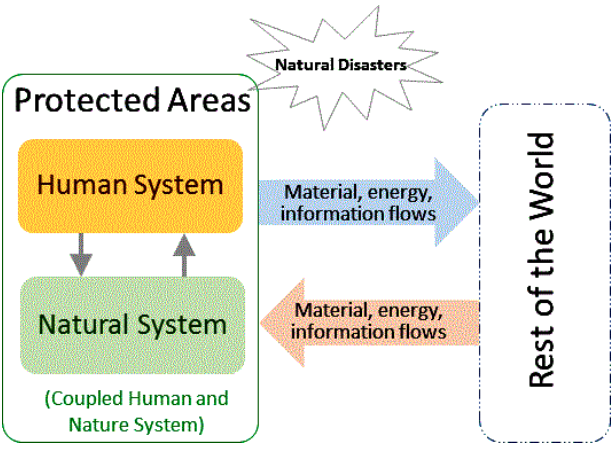
Fig. 1 . Exchange of energy, materials, and information between protected areas and the rest of the world through telecouplings undergoing natural disasters. Natural disasters may drastically change these telecouplings and generate substantial socioeconomic and ecological impacts in protected